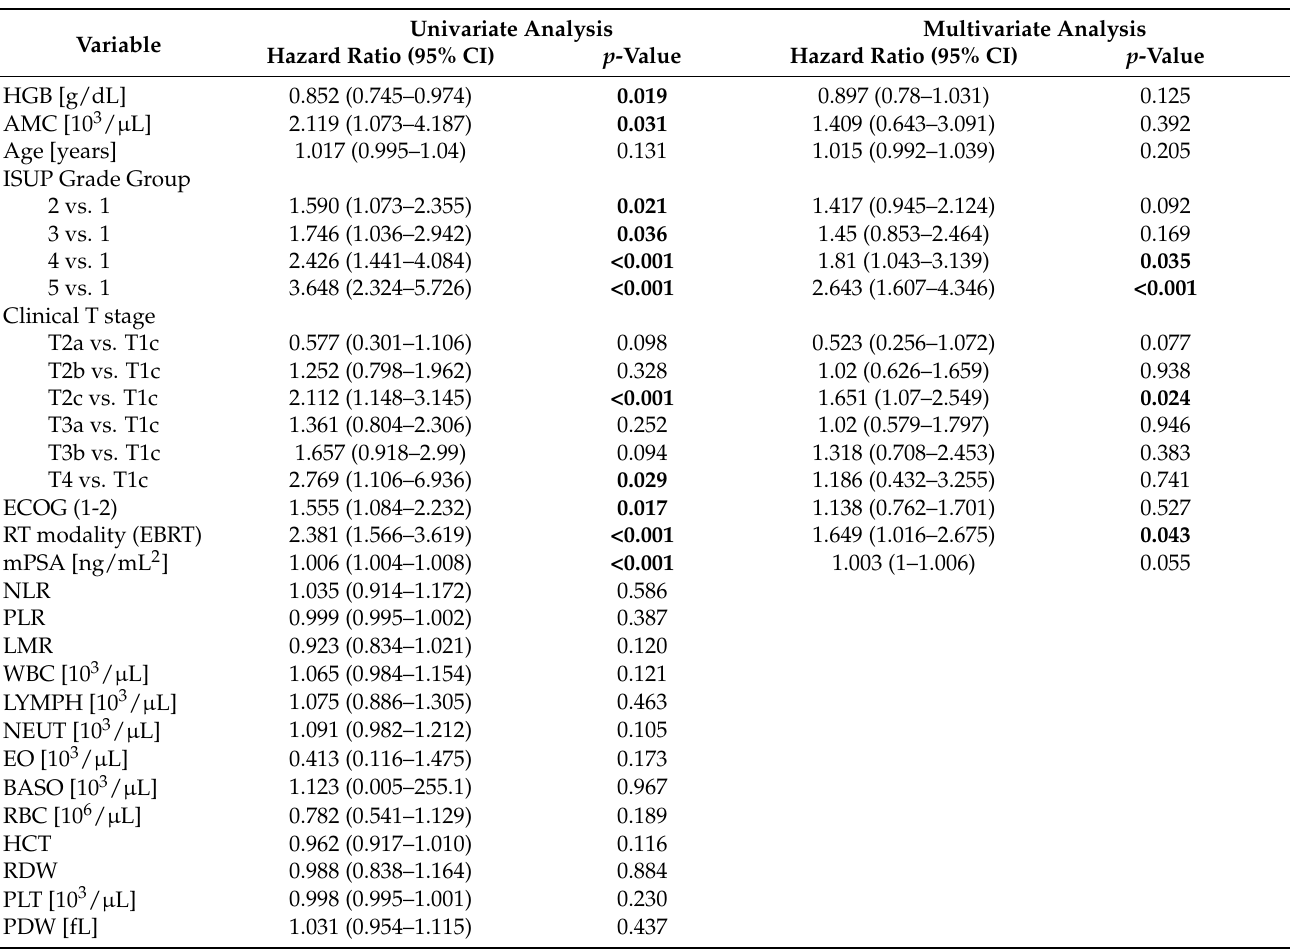
Table 3. Cox Proportional Hazards Regression Analysis for freedom from distant metastases in patients treated with radiation therapy for localized or locally advanced prostate